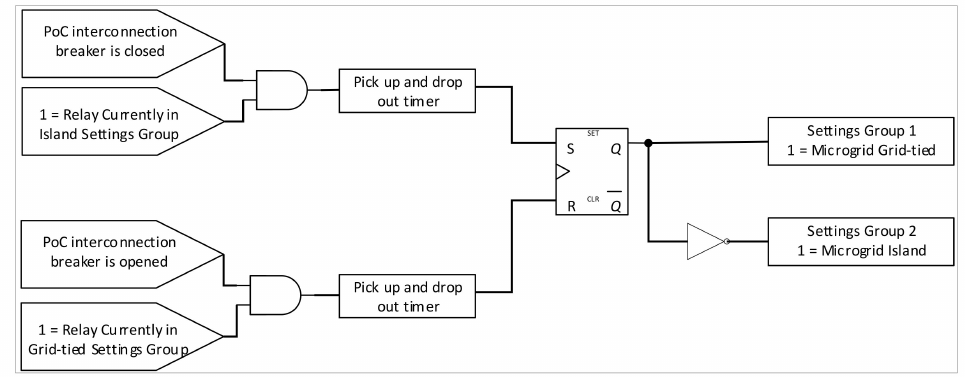
Figure 3. An example, simplified protection logic using the Control System Countermeasures